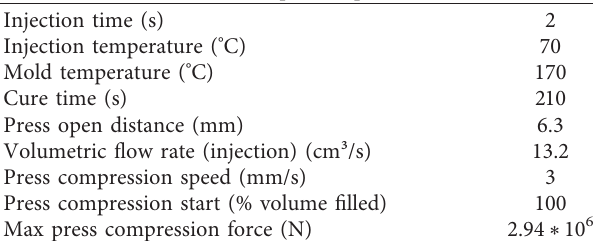
Figure 6: (a) 3D mesh of the circular sector with an angle of 90 ° ; (b) geometry of the rubber diaphragm (dimensions in (mm)); (c) 3D representation of the complete injection shot (mold cavity); (d) compression moving (green) and fixed (yellow) surfaces. Table 3: Main process